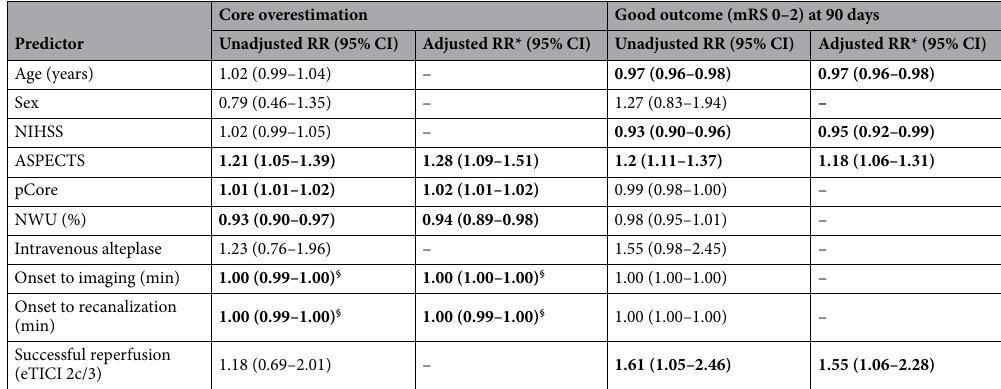
Table 2. Univariable and multivariable binary logistic regression analysis of the effect of baseline, imaging, and procedural variables on pCore overestimation and good functional outcome (mRS 0–2). mRS modified Rankin Scale; RR relative risk; NIHSS National Institutes of Health Stroke Scale; ASPECTS Alberta Stroke Program Early CT Score; NWU net water uptake; eTICI expanded Thrombolysis in Cerebral Infarction. *Significant predictors in univariable regression were used to build the multivariable model. § Values are rounded to the nearest decimal. Significant associations are shown in